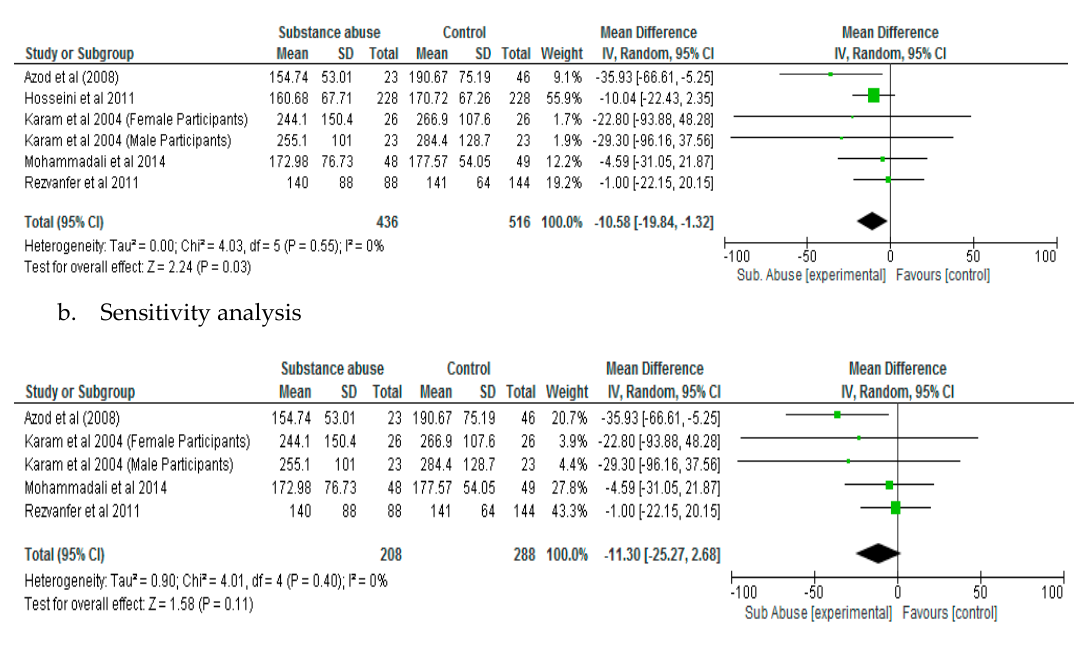
Figure 4. Results of Fasting Blood Glucose (mg/dL).